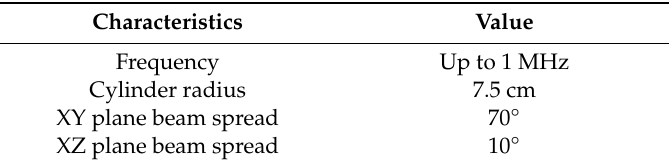
Table 2. Transducer requirements [12].